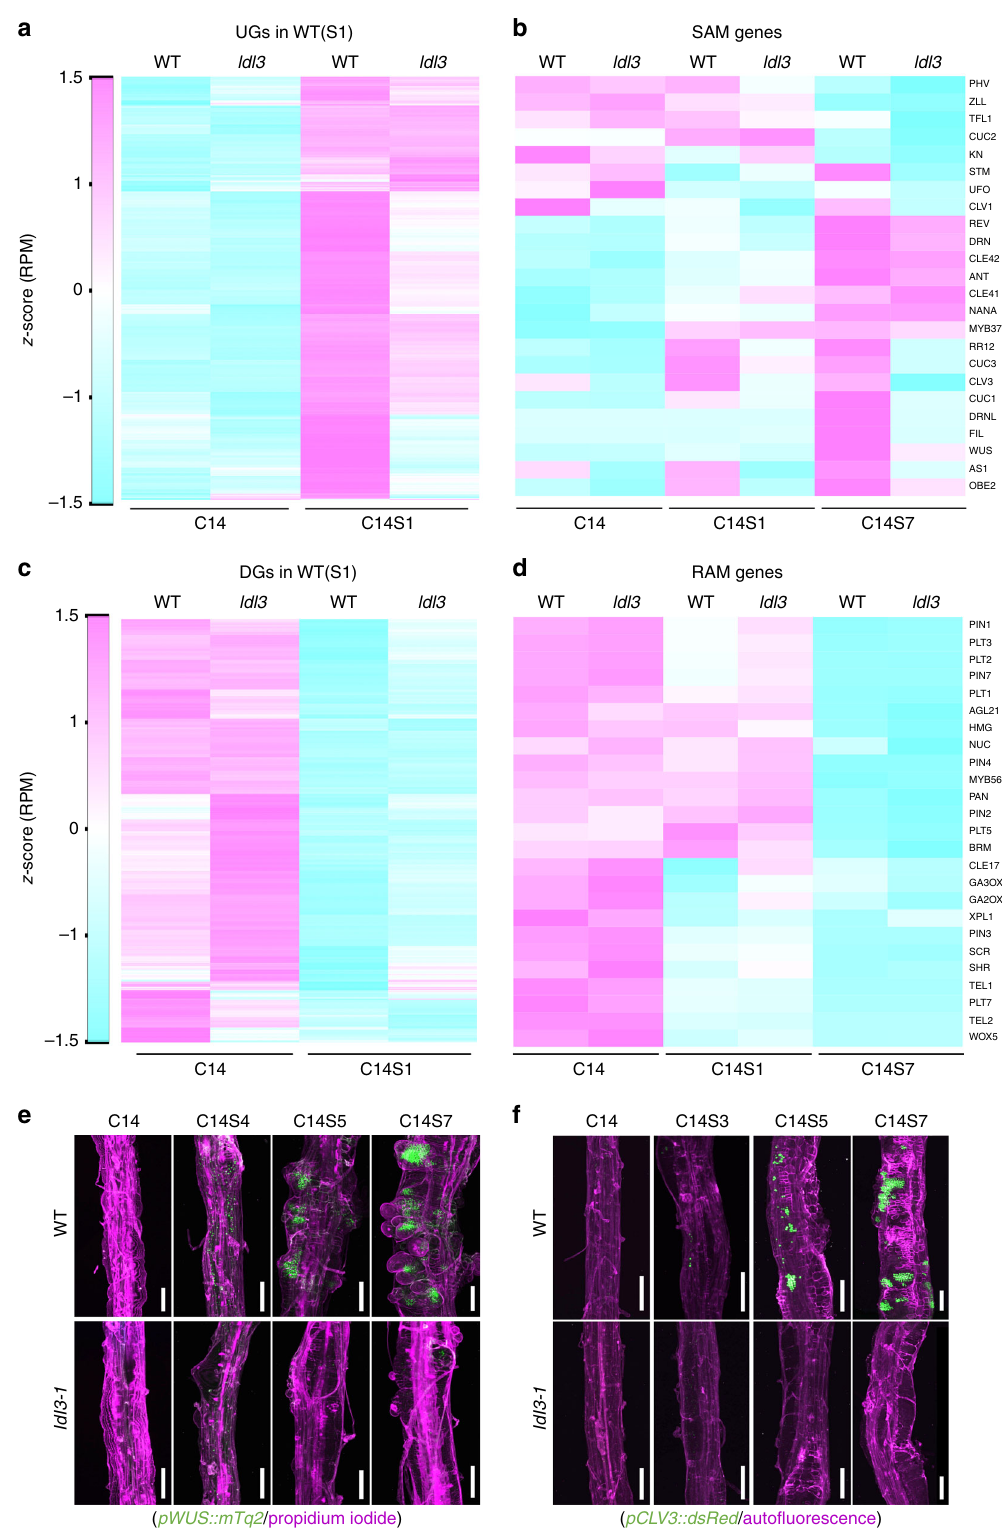
Fig. 3 LDL3 activates genes for the acquisition of shoot traits upon shoot induction. Comparing transcriptome pro fi les of wild type (WT) before and after shoot induction (C14 vs C14S1 or C14 vs C14S7) identi fi ed genes that are up- or down-regulated (FC > 1.25 or < 0.8, p < 0.01) in response to shoot induction at early or late stages in WT (UGs_S1, DGs_S1, UGs_S7, and DGs_S7). a – d Expression changes of UGs_S1 ( a ), key developmental genes for SAM ( b ), DGs_S1 ( c ), and key developmental genes for RAM ( d ) upon shoot induction in WT and ldl3 . Heat maps show relative expression levels for the genes by z -scores of read counts per million mapped reads (RPM). e , f Expression patterns of SAM reporters (green), pWUS::mTq2 ( e ), and pCLV3::dsRedN7 ( f ), in calli of WT and ldl3 before and after shoot induction. All panels are combined images of two sequential projections. Cellular outlines (magenta) were visualized with PI staining ( e ) or auto fl uorescence ( f ). Scale bars: 100 μ m. See also Supplementary Fig. 3, Supplementary Data 3 and